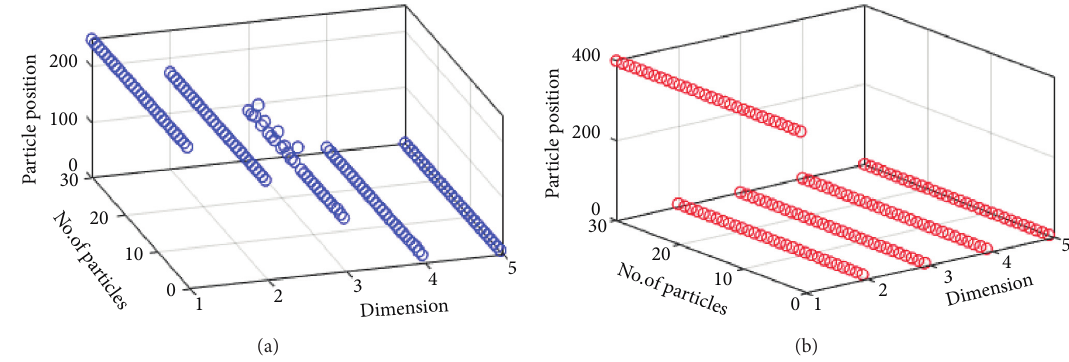
Figure 13: Particle convergence after 300 iterations. (a) PSO. (b)